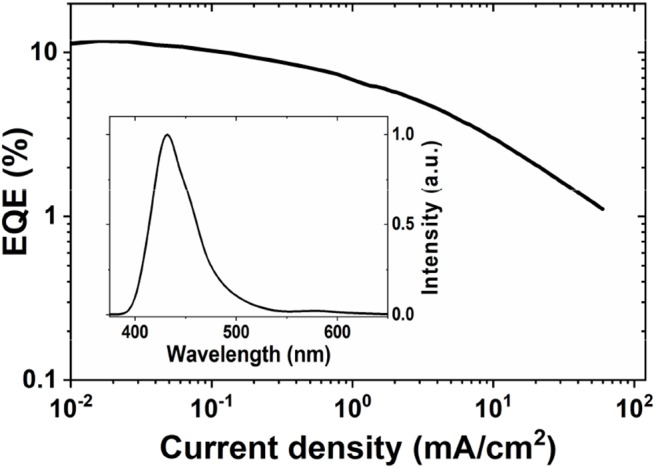
EQE vs. current density curve of 5 vol% doped devices of AuBZI. The EL spectrum is shown in the inset. Device architecture: ITO/10 nm HATCN/40 nm TAPC/40 nm UGH3:5 wt % AuBZI /40 nm TPBI/1 nm LiF/100 nm Al.